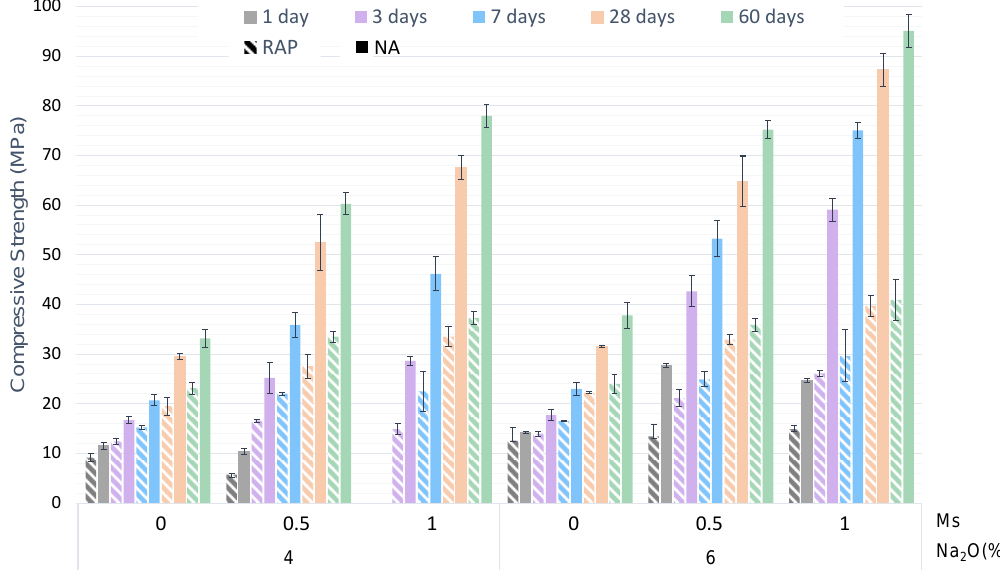
Figure 8. Compressive strength of mortars.